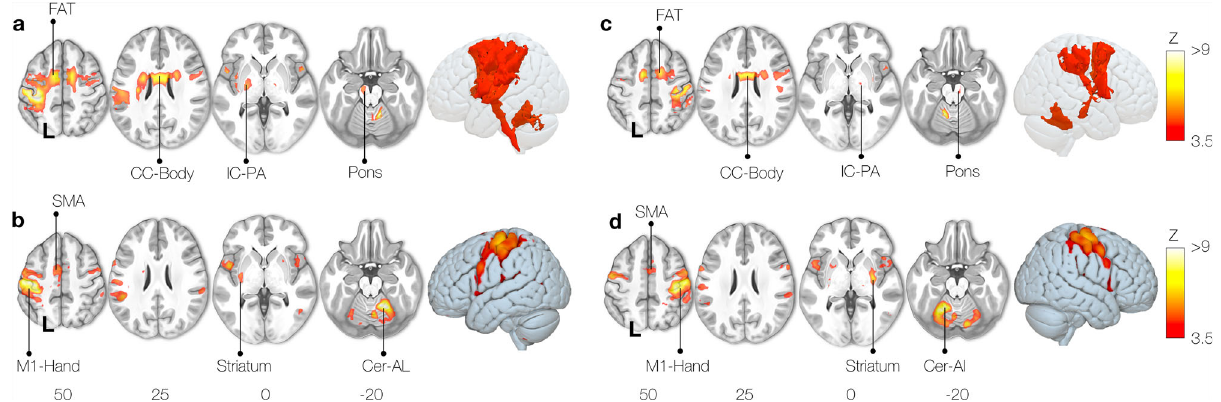
Fig. 3 Motor task activation network for fi nger-tapping. Right hand ( a : functionnectome, b : classic) and left hand ( c : functionnectome, d : classic) fi nger- tapping activation maps. FAT: Frontal Aslant Tract, CC-Body: Corpus Callosum body, M1: Primary motor cortex, SMA: Supplementary motor area, Cer-AL: Cerebellar anterior lobe, IC-PA: Internal capsule posterior